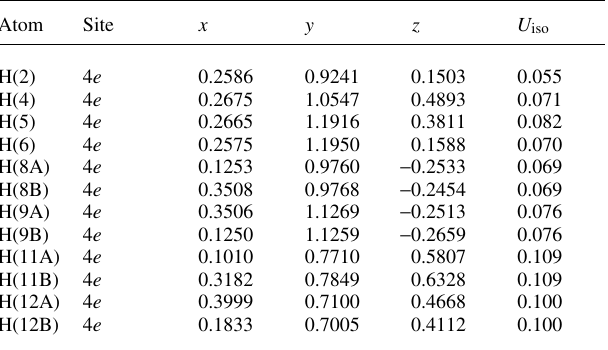
Table 2. Atomic coordinates and displacement parameters (in Å 2 )